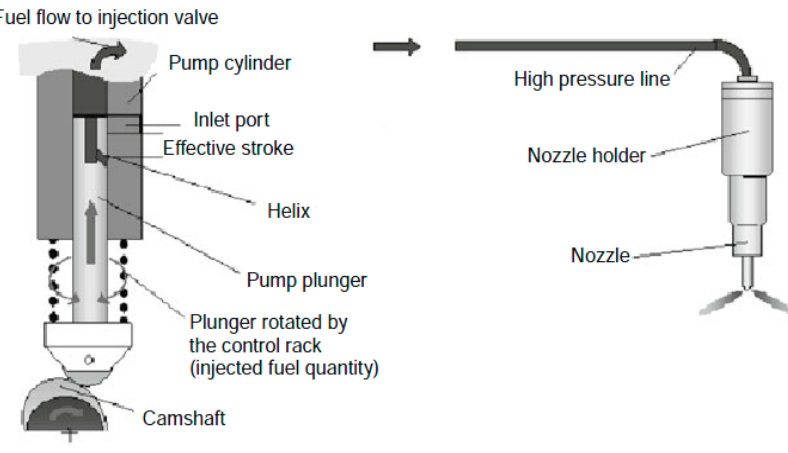
Figure 21. Design and functional principle of the inline pump injection system.